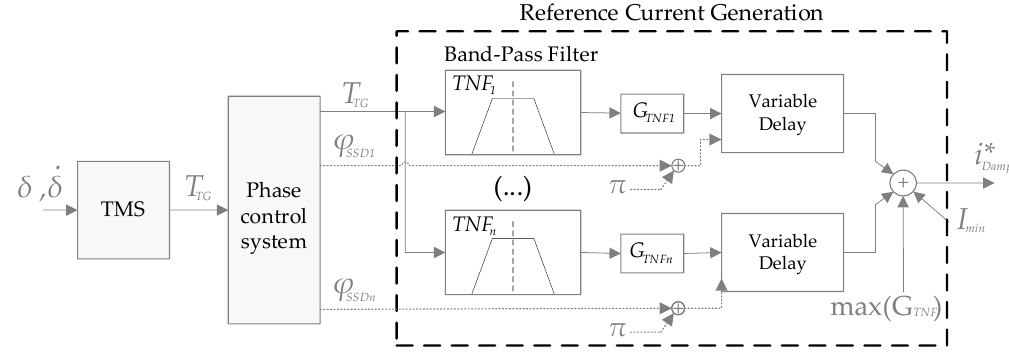
Figure 2. Proposed sub-synchronous damper (SSD) control system control including the phase control.